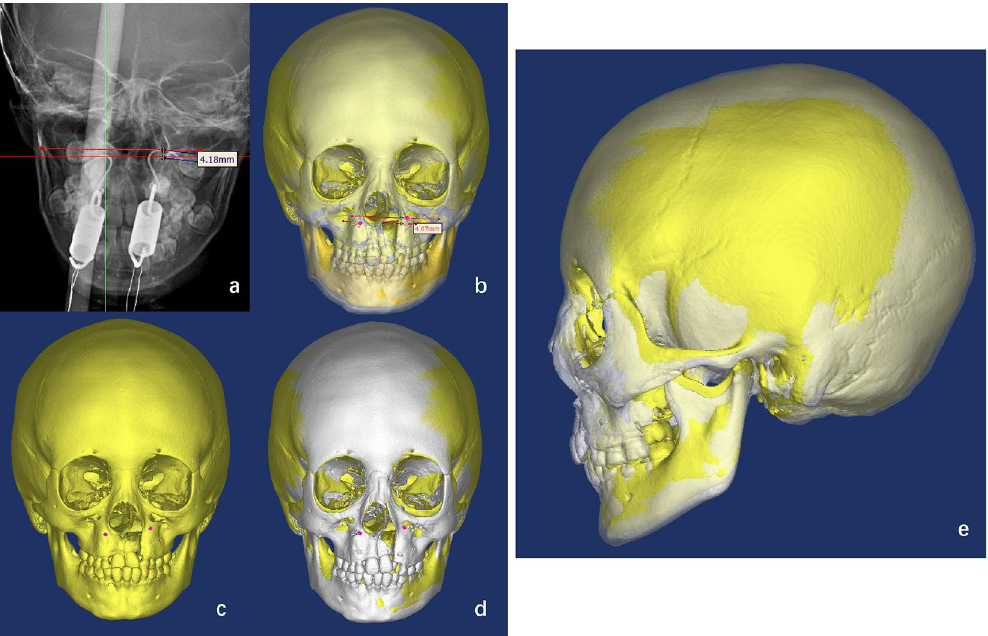
Figure 6. Evaluating the safety and effectiveness of the OSNS. ( a ) A cranial X-ray was performed to clarify the position of the traction hook; ( b – d ) The preoperative 3D reconstructed image was used as the base coordinate system, and the 3D cranial model was reconstructed after treatment (after removal of the traction hook), fitted to the base coordinate system to measure the changes in the morphological position of the patient’s maxilla; ( e ) The morphological position of the patient’s maxilla before and after treatment.